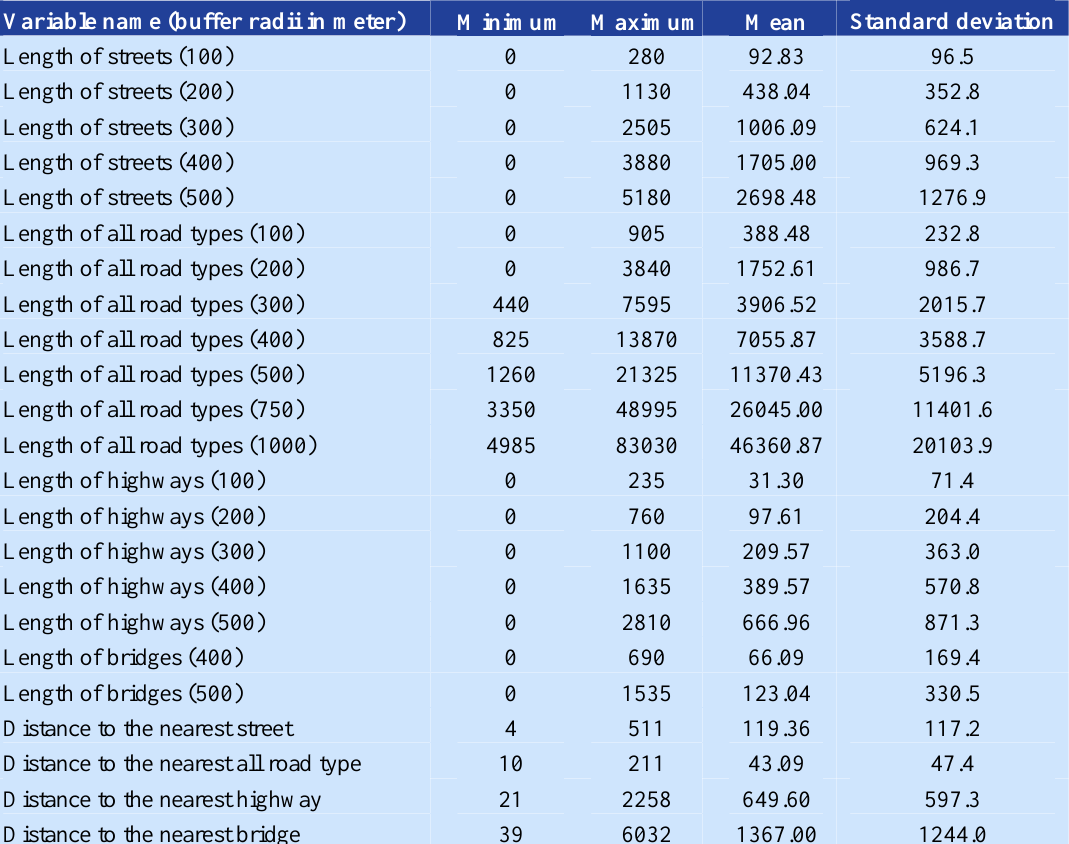
Table 2. Summary of the traffic surrogates variables Variable name (buffer radii in meter) Minimum Maximum Mean Standard deviation Length of streets